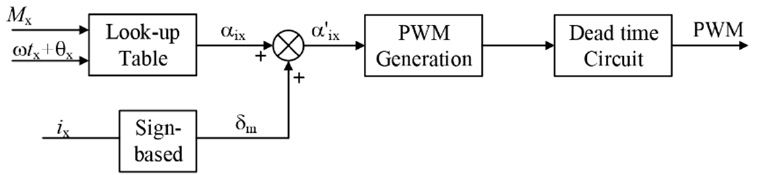
Figure 11. Dead-time compensation by inserting a margin time. Table 1. Margin time insertion rules.